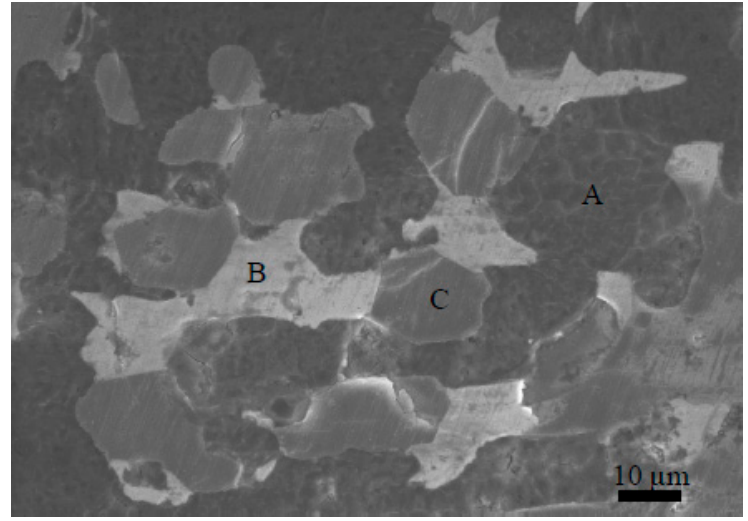
Figure 2. SEM micrographs and elements distribution images on the surface of the La 7.0 Mg 75.5 Cu 17.5 alloy. Table 2. EDS analysis of the La 7.0 Mg 75.5 Ni 17.5 alloy.